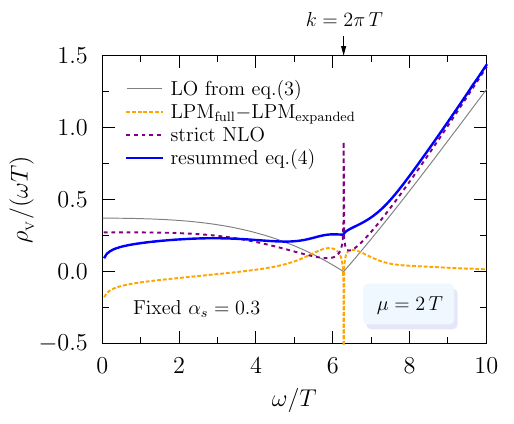
Figure 3. The vector channel spectral function, plotted as a function of ω for k = 2 π T and with α s = 0 . 3. This illustrates both the strict loop expansion from sec. 4 (dashed) and the relevant LPM part from sec. 5 (dotted) where the log-divergence for ω ≈ k from (16) is evident. Crucially, the prescription of eq. (4) gives a result (solid) that is both finite and continuous at the light cone. (For comparison, the free result is also shown.)